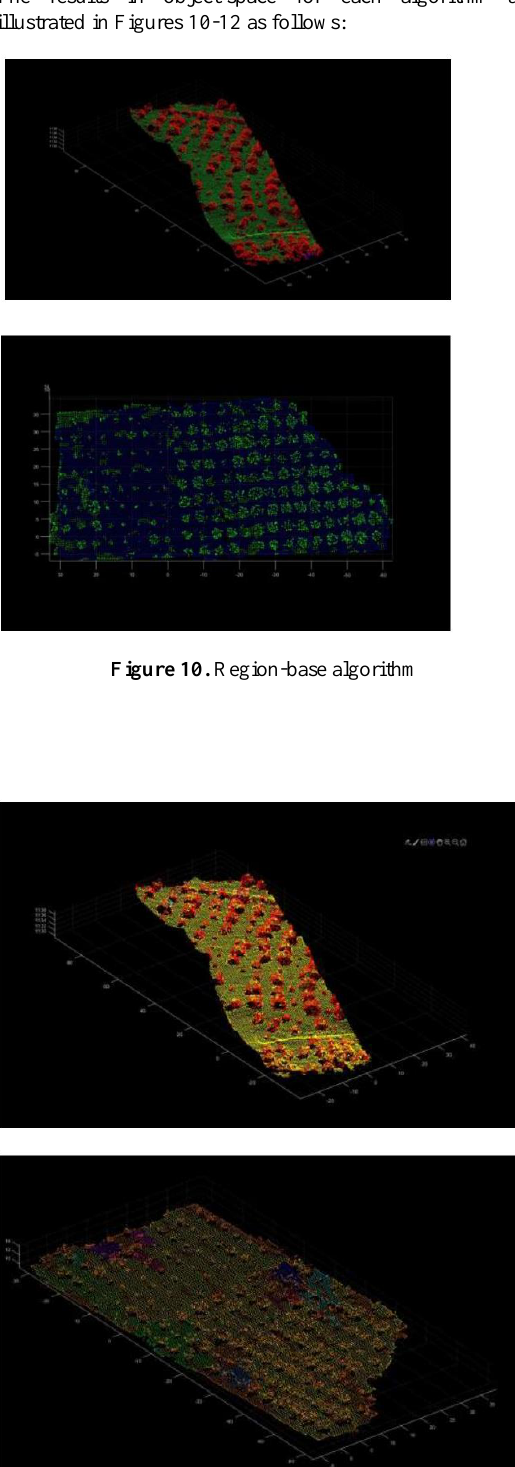
Figure 11. Surface-Normal algorithm